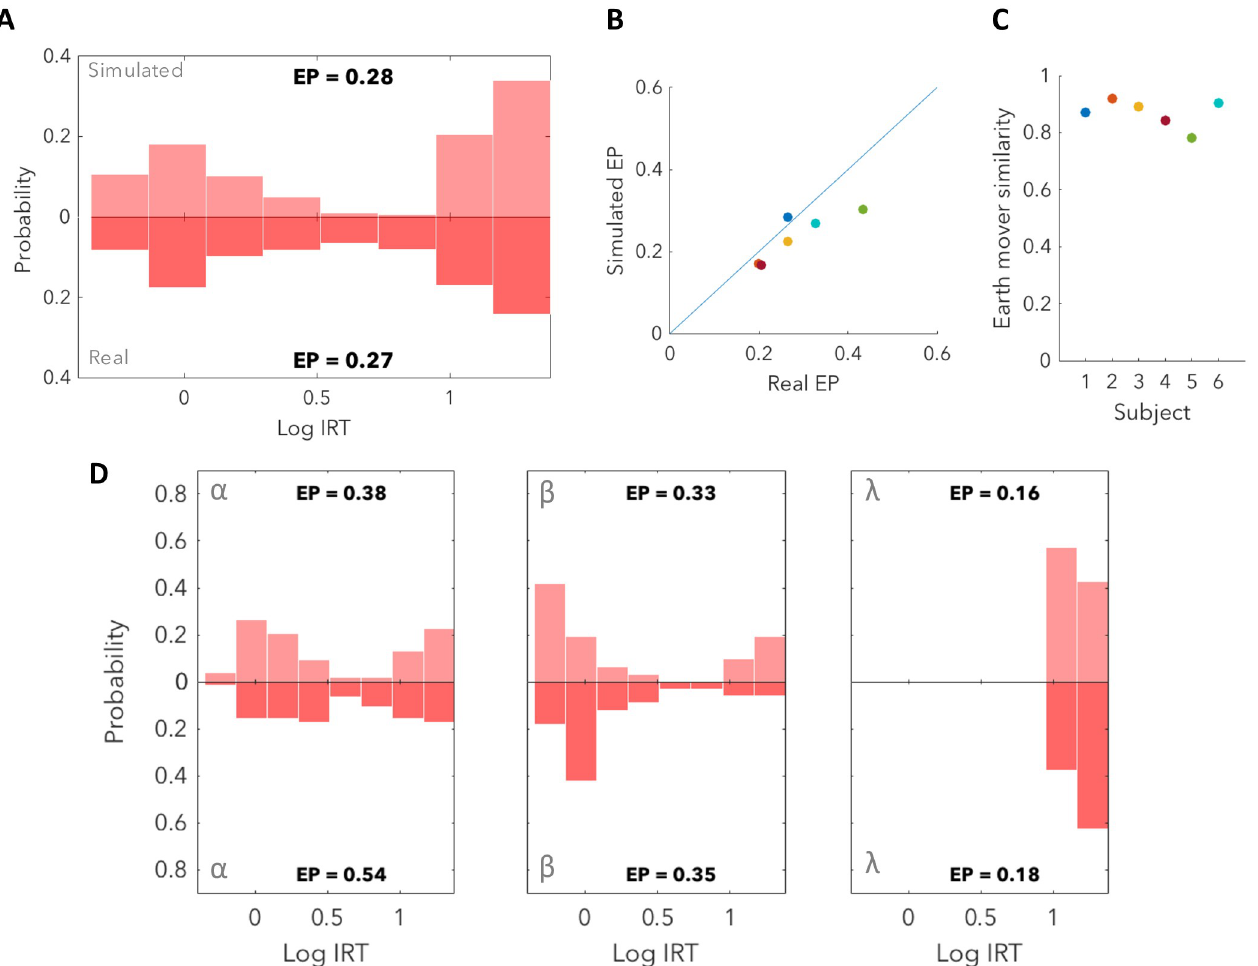
Fig 6. Simulated responses capture the process of mistaken inference. ( A ) By fitting model parameters and simulating responses (upper), we are able to recover the distribution of short and long IRTs observed in the data (lower)(subject 1). ( B ) Simulated EPs are similar to real EPs except for subject 5 (green). ( C ) The simulated distributions of IRTs have earth mover’s similarities to the real distribution above 0.8 except for subject 5. ( D ) By sorting responses into regions as in Fig 3B. we find that simulated distributions are similar to the real distributions indicating that our model is able to capture the confusion